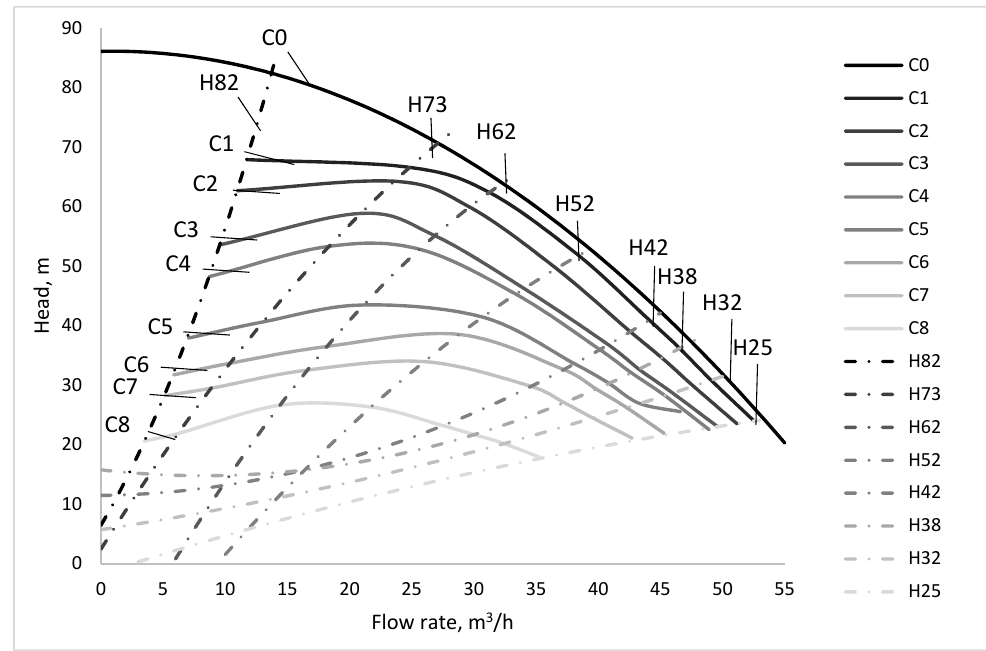
Figure 3. Changing of the centrifugal pump characteristic curve with air addition to the system. Table 2. Parameters of characteristic curves shown in in this paper.